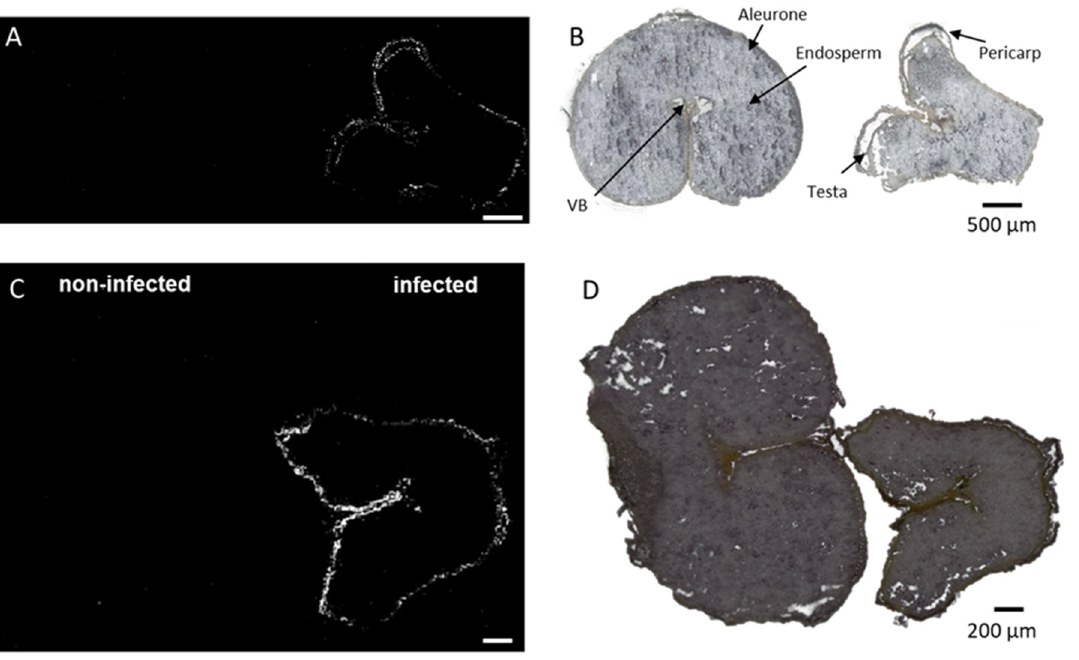
Figure 5. Spatial distribution of coumaroylagmatine in durum ( A , B ) and common wheat ( C , D ) cross-sections. Coumaroylagmatine [M + H] + m/z 277.1659 was found exclusively in the outer cuticle of the pericarp in infected seeds. Optical image of durum ( B ) and common wheat ( D ) seed sections with major morphological features labeled. MS images were generated with ( A ) 336 × 138 pixels; 20 µm pixel size; m/z bin width: ±5 ppm; scale bars: 500 µm; ( B ) 300 × 220 pixels; 15 µm pixel size; m/z bin width: ±5 ppm; scale bars: 200 µm.